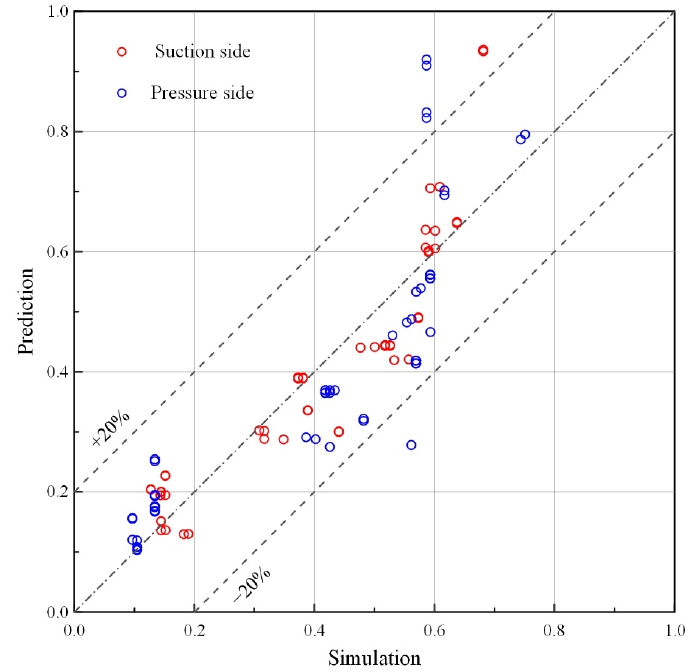
Figure 22. Distribution of simulation–prediction pairs.